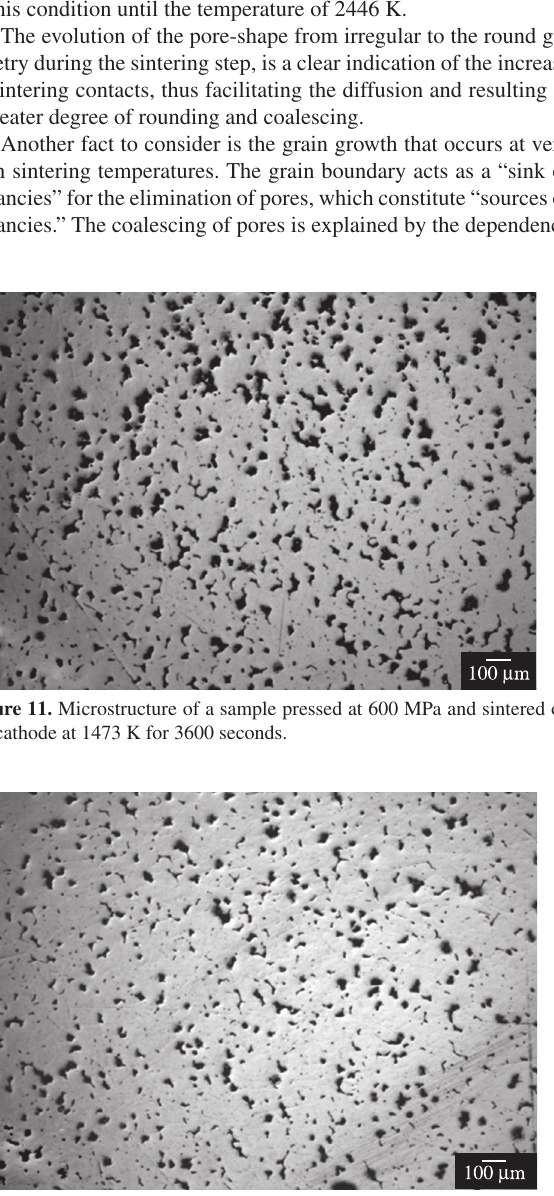
Figure 12. Microstructure of a sample pressed at 600 MPa and sintered on the cathode at 1523 K for 3600 seconds. Table 4. Gibbs free energy for formation of oxides and titanium hydrides 14 .